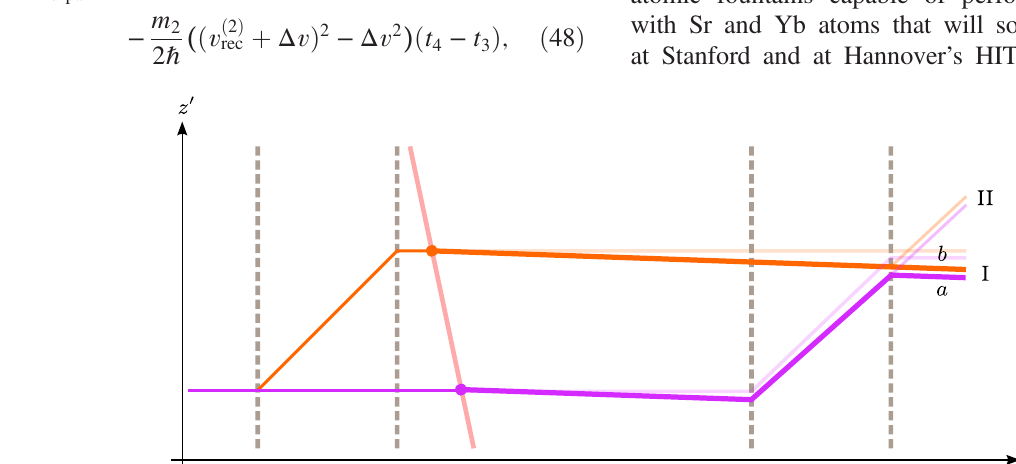
FIG. 9. Central trajectories in the freely falling frame showing how the residual recoil from the initialization pulse leads to slightly modified trajectories for the excited state. Nevertheless, the phase shift, as well as the interpretation of the doubly differential measurement in terms of proper-time differences, remains